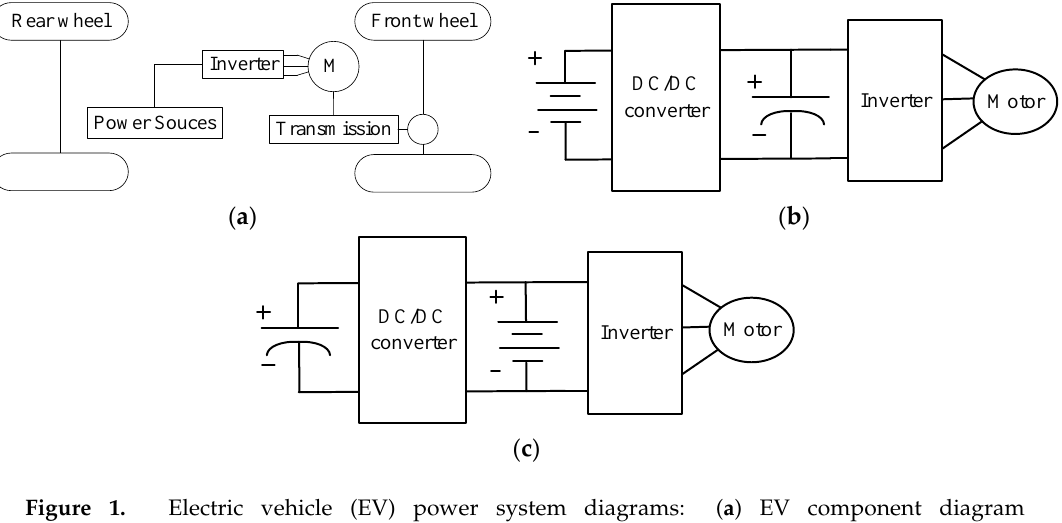
Figure 1. Electric vehicle (EV) power system diagrams: ( a ) EV component diagram ( b ) Electric vehicle (EV) power system diagrams: ( a ) EV component diagram Battery/supercapacitor (SC) topology ( c ) SC/Battery topology. ( b ) Battery/supercapacitor (SC) topology ( c ) SC/Battery